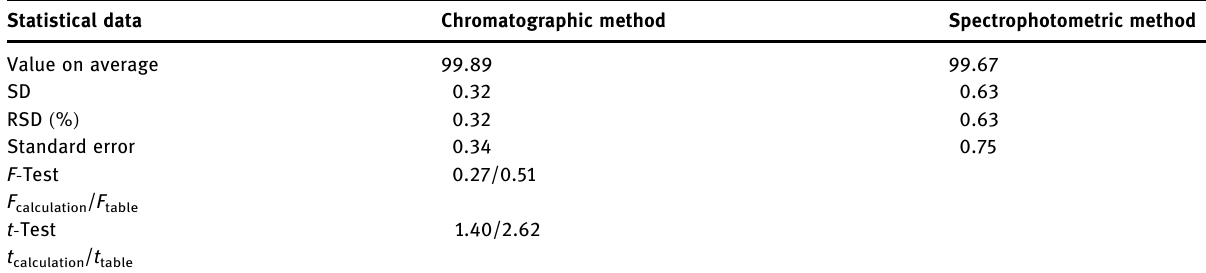
Table 8: Statistical comparison ( n = 6